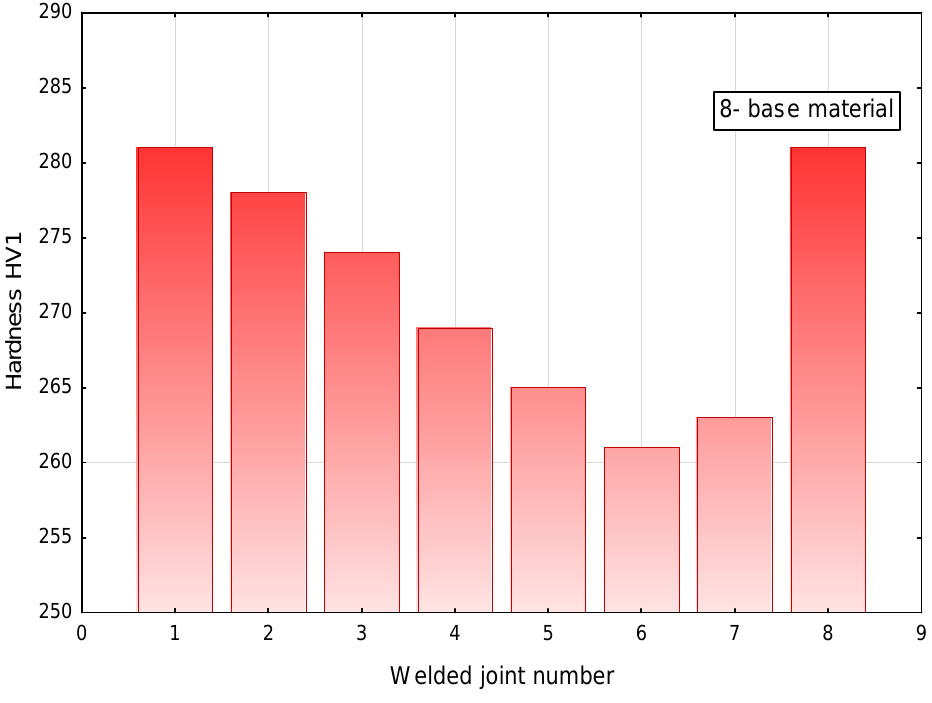
Figure 17. Averaged hardness in the HAZ area of the T ‐ joints.